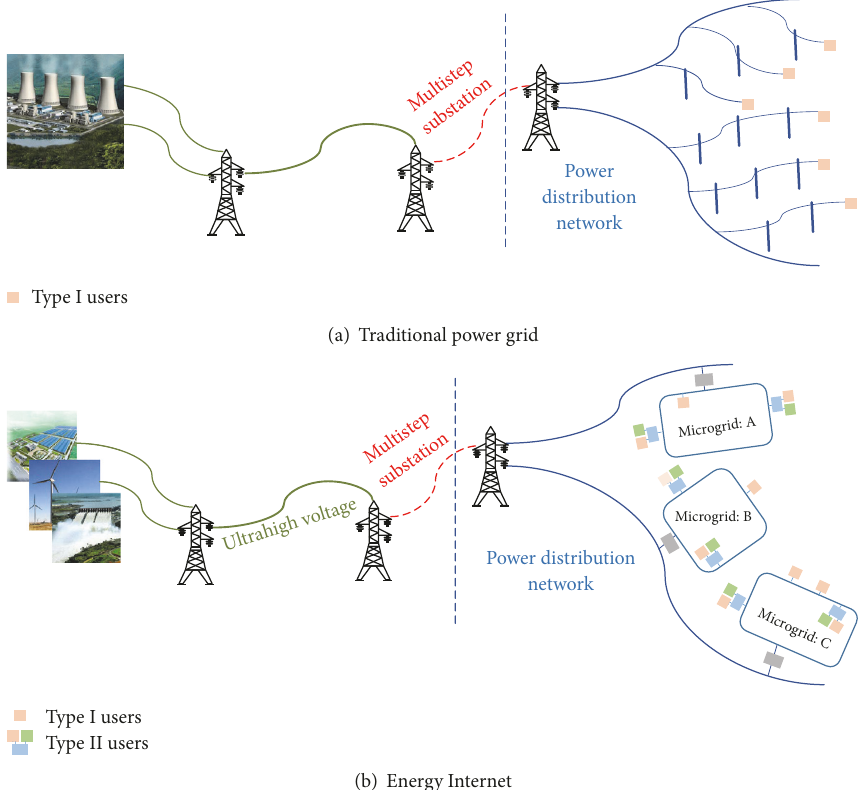
Figure 2: Differences between traditional power grid and energy Internet. Type I users (traditional users) represent those that just equal common loads, while Type II users (distributed energy users) denote those that possess abilities of power generation and storage besides consumption)